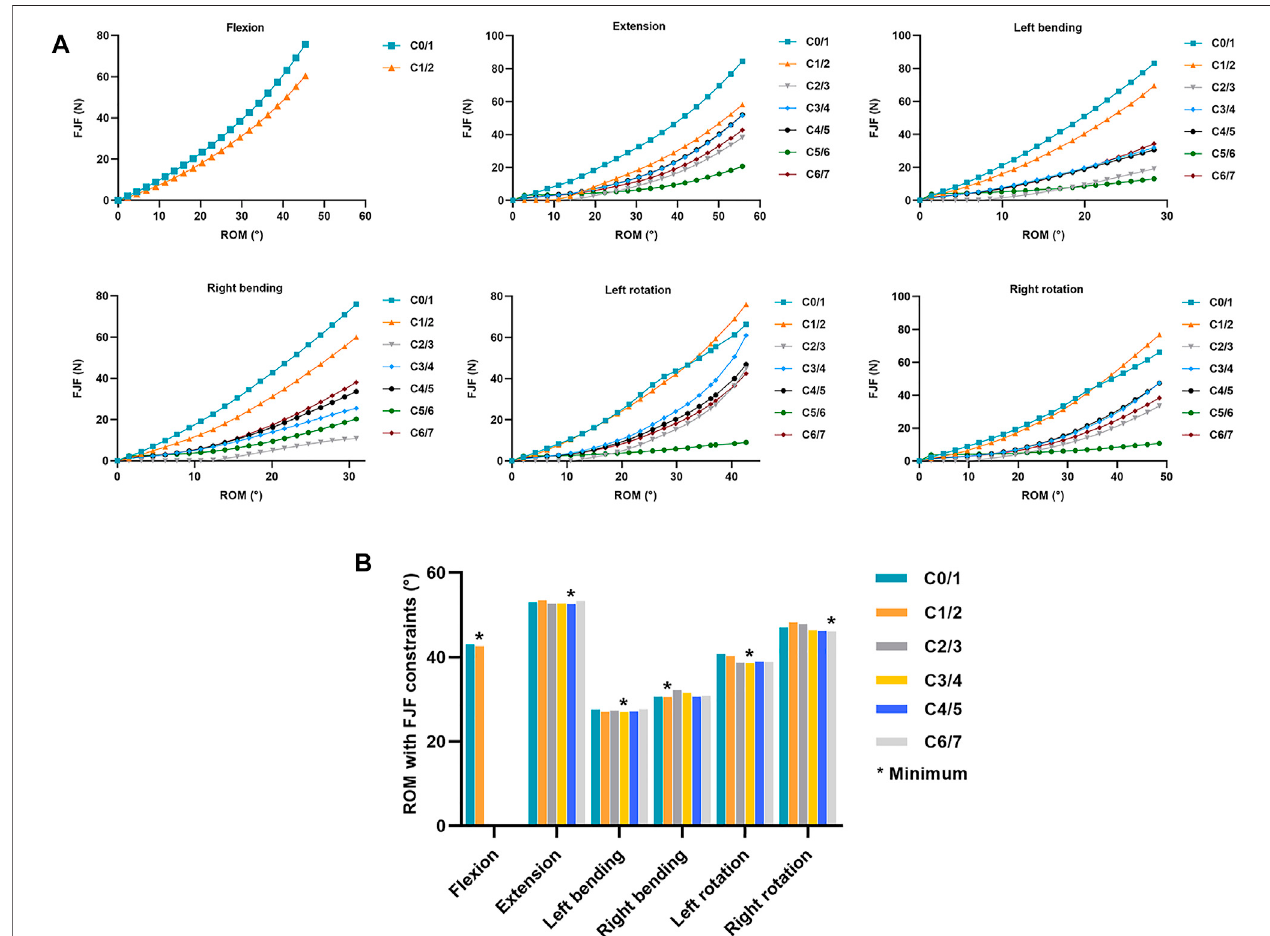
FIGURE 5 | Changes of FJF of non-fused segments in the ACDF model with increasing total C0 – C7 ROM (A) FJF values in each segment change with increasing totalC0 – C7ROMintheACDFmodel. (B) ROMswerecalculatedwithFJFconstraintsintheACDFmodel,and theminimumROMineachmotiondirectionwaslabeled*.